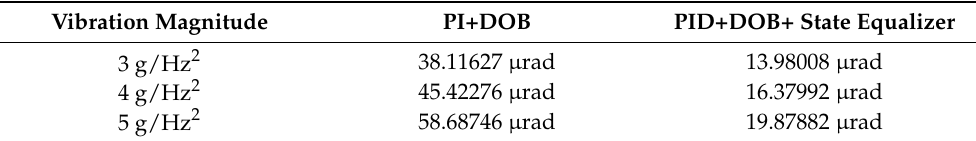
Table 3. Comparison of stable accuracy of the two algorithms. Vibration